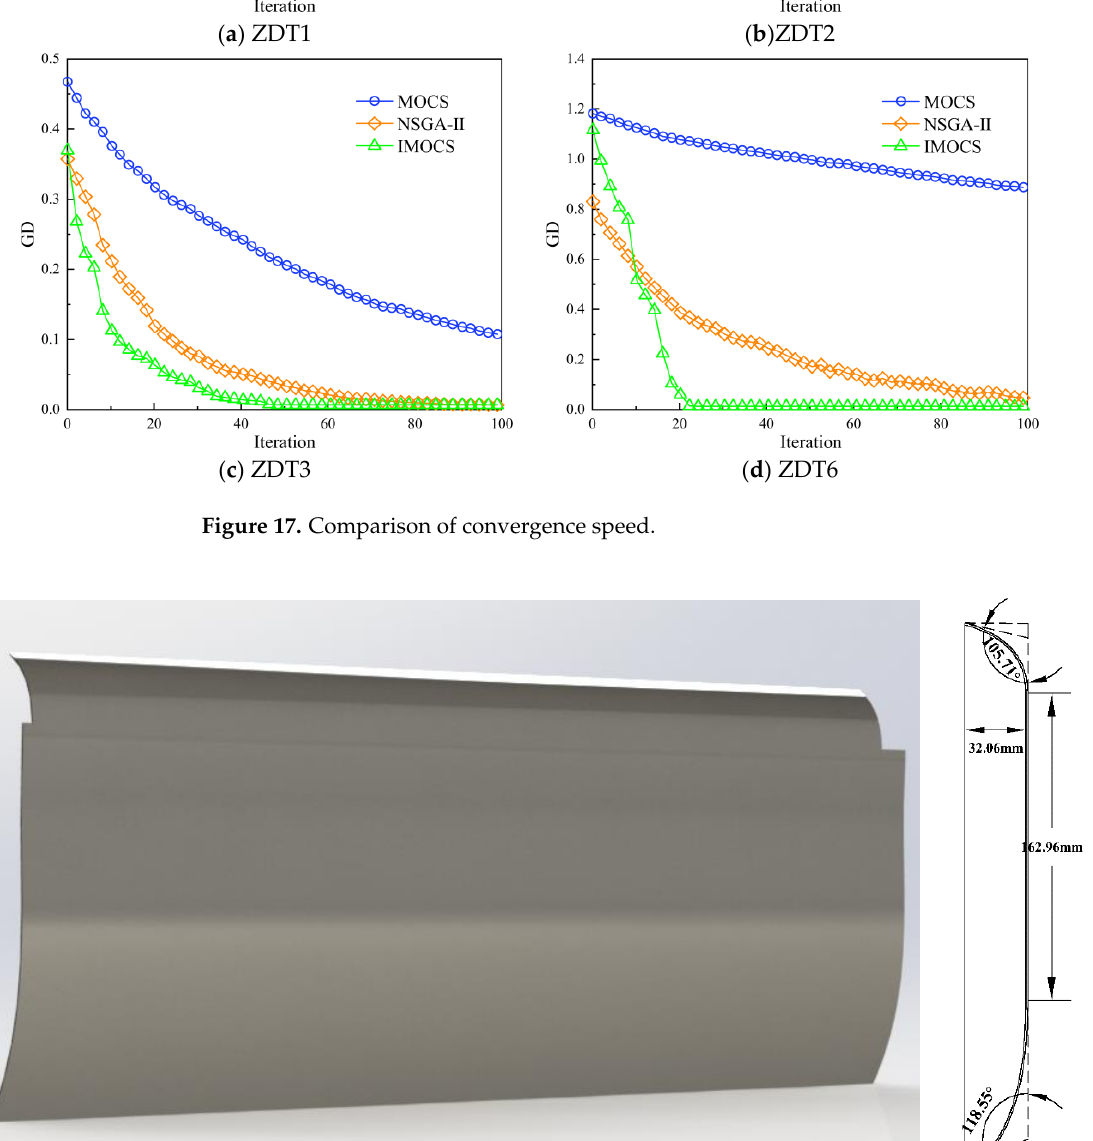
Figure 18. Guide vane diagram.